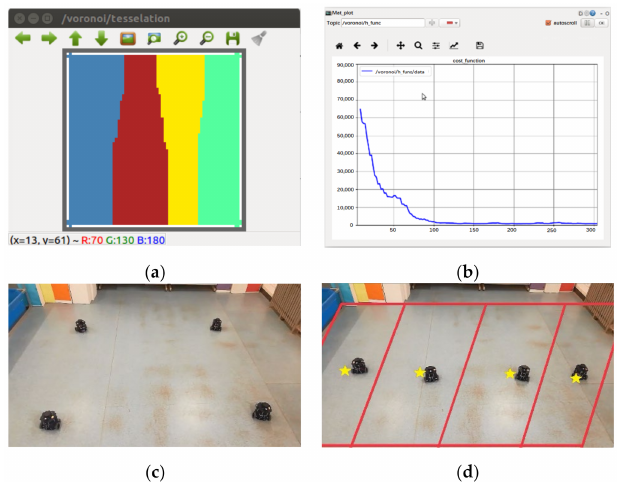
Figure 19. Linear formation experiment: ( a ) density function distribution; ( b ) cost function; ( c ) initial position; ( d ) final